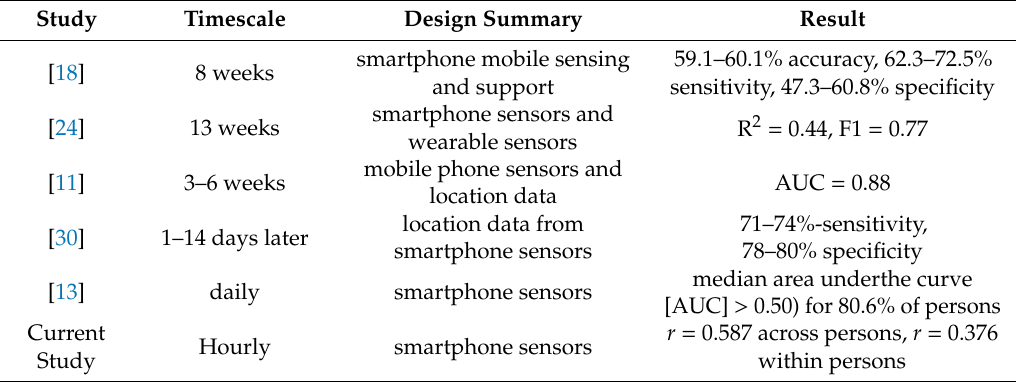
Table 1. This table describes prior studies that have used predictive modeling to predict future depressive symptoms and have reported predictive outcome metrics among general samples or samples high in clinical depression, but not meeting criteria for other primary diagnoses (e.g., bipolar